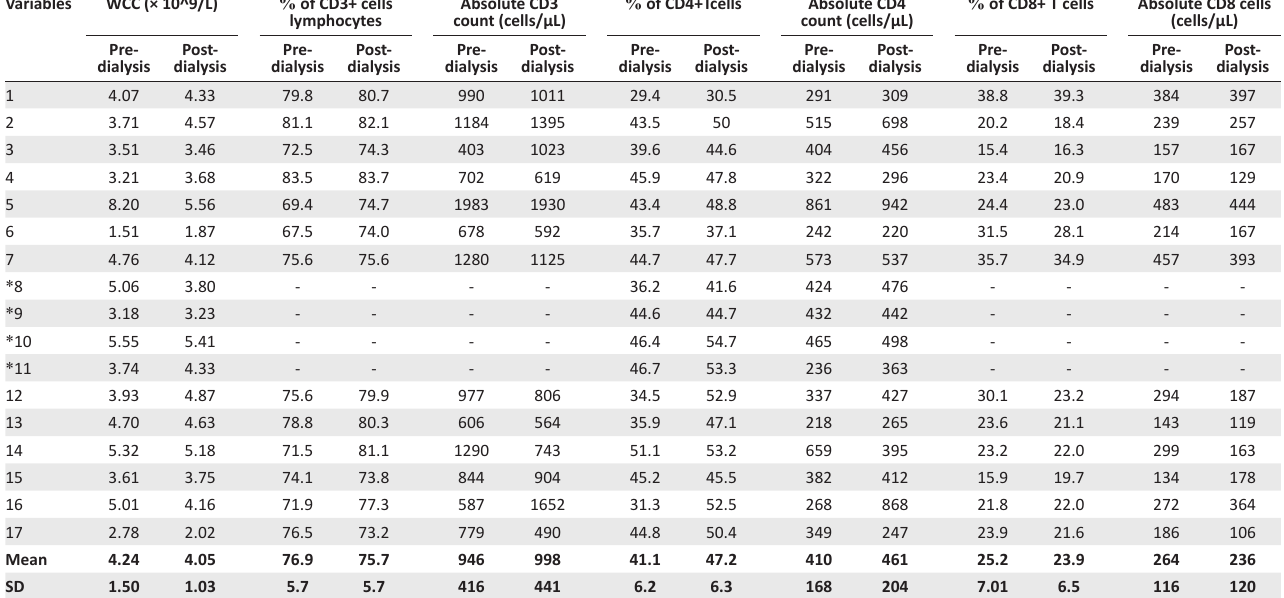
TABLE 3: Measured parameters of the study